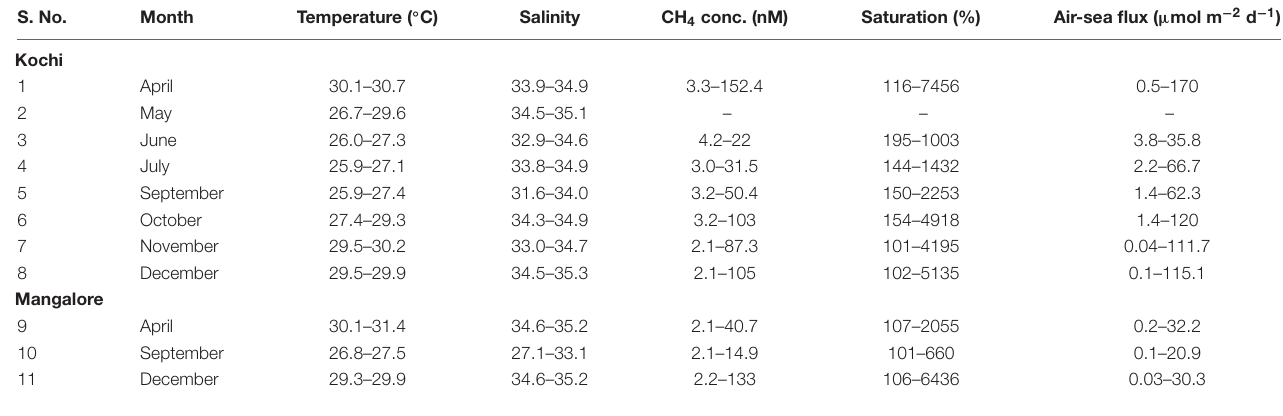
TABLE 1 | Monthly variation in temperature, salinity, and CH 4 saturation and fluxes in the surface waters of SEAS. S.